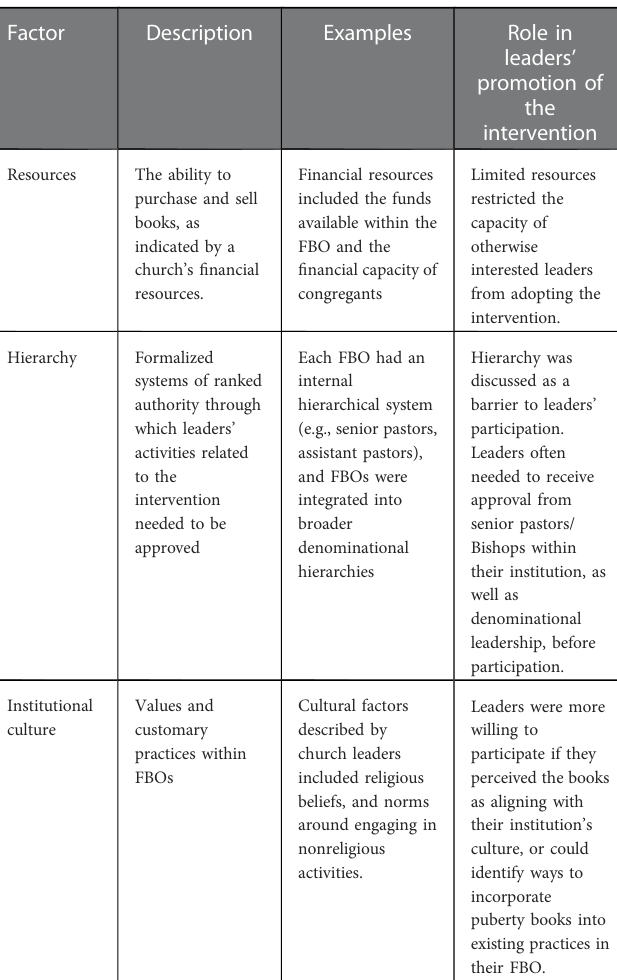
TABLE 3 The impact of institutional-level factors on church leaders ’ promotion of puberty